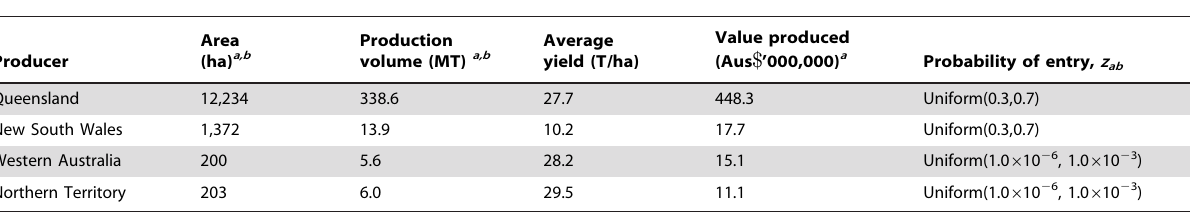
Table 2. Australian banana production statistics by region.